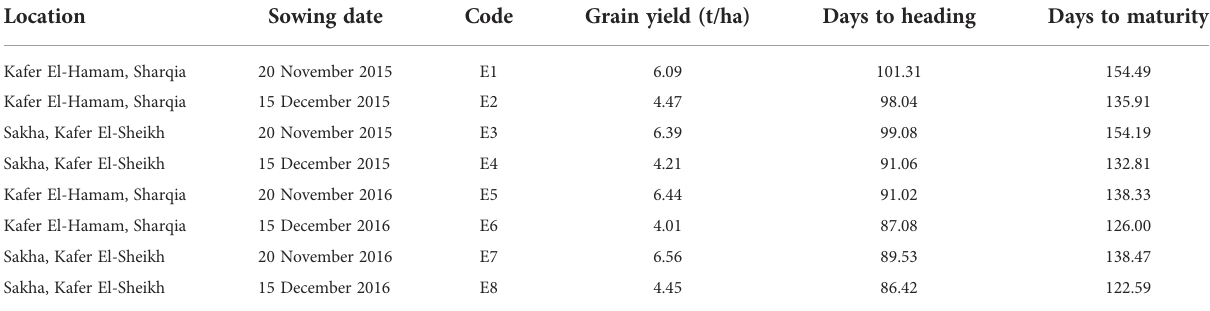
TABLE 1 Description of the performed fi eld